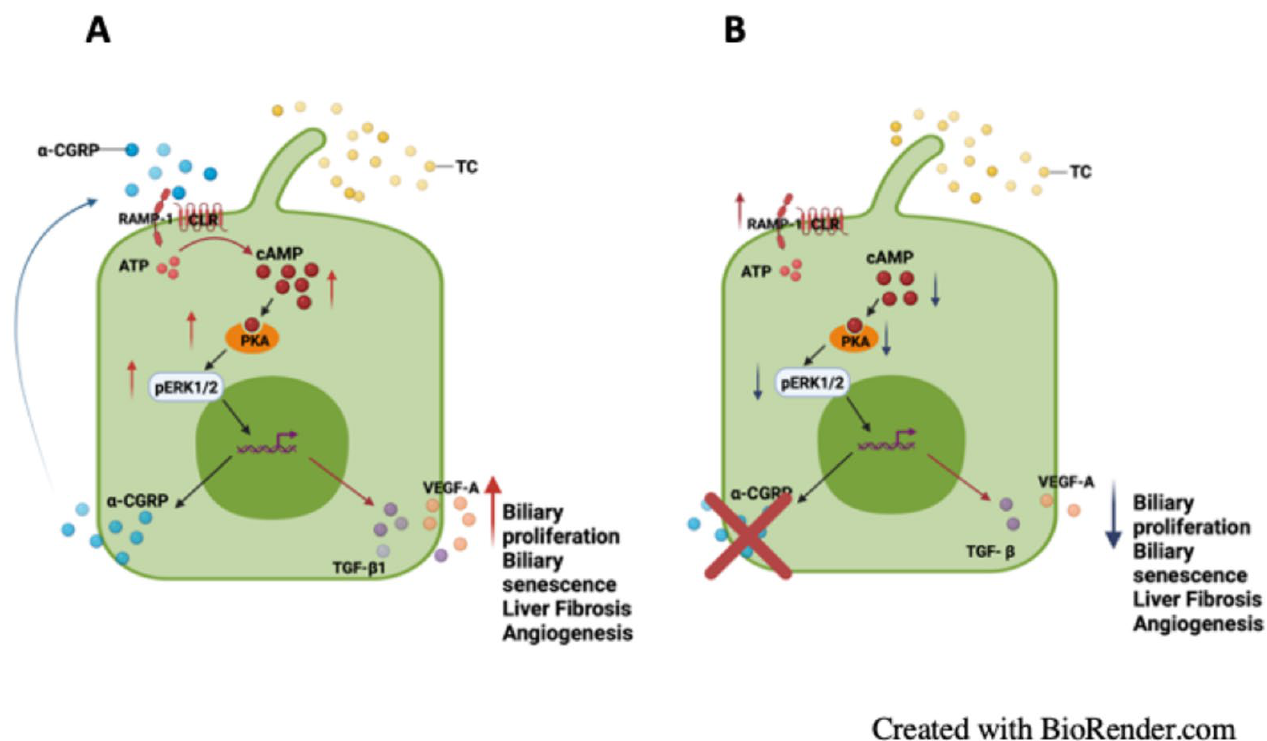
Figure 11. Working model illustrating the effects of TC on liver phenotypes in WT and α -CGRP −/− mice. ( A ) TC effects on liver phenotypes are due to changes in hepatic BA composition leading to enhanced expression of the cAMP/PKA/ERK signaling pathway. As a consequence, cholangiocytes acquire a neuroendocrine phenotype and promote the release of α -CGRP neuropeptide. By an autocrine mechanism, α -CGRP binds CGRP-receptor components (CALRL, RAMP-1, and RCP) that are expressed on cholangiocytes and promotes cholangiocyte proliferation, liver fibrosis, and angiogenesis. ( B ) In the absence of α -CGRP neuropeptide, cholangiocytes overexpress CGRP-receptor components (CALRL, RAMP-1, and RCP) as a compensatory mechanism and reduce biliary proliferation, biliary senescence, and liver fibrosis and angiogenesis. Graphic illustration was created by BioRender.com (accessed on 2 February